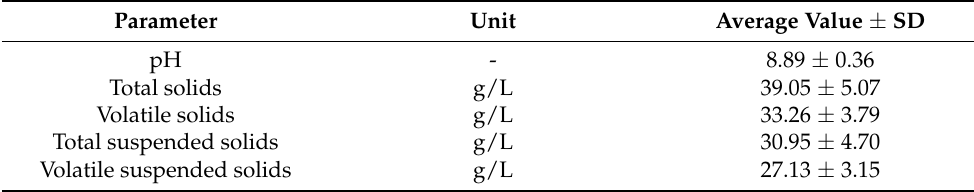
Table 3. Main physicochemical characteristics of the inoculum.